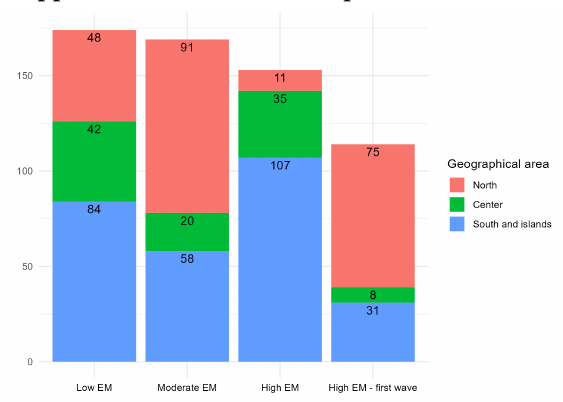
Figure A1. Number of LMAs in the clusters divided by geographical